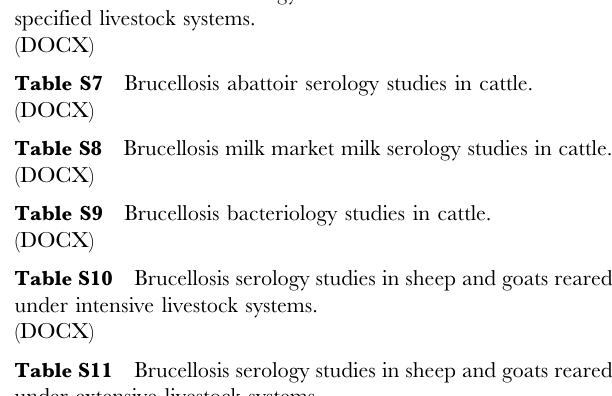
Table S1 Rejected brucellosis serology studies in cattle. Table S2 Rejected brucellosis serology studies in sheep and goats. Table S3 Brucellosis serology studies in cattle reared under intensive livestock systems. Table S4 Brucellosis serology studies in cattle reared under extensive livestock systems. Table S5 Brucellosis serology studies in cattle undertaken in extensive and intensive livestock systems in parallel. Table S6 Brucellosis serology studies in cattle reared under non- specified livestock systems. Table S7 Brucellosis abattoir serology studies in cattle. Table S8 Brucellosis milk market milk serology studies in cattle. Table S9 Brucellosis bacteriology studies in cattle. Table S10 Brucellosis serology studies in sheep and goats reared under intensive livestock systems. Table S11 Brucellosis serology studies in sheep and goats reared under extensive livestock